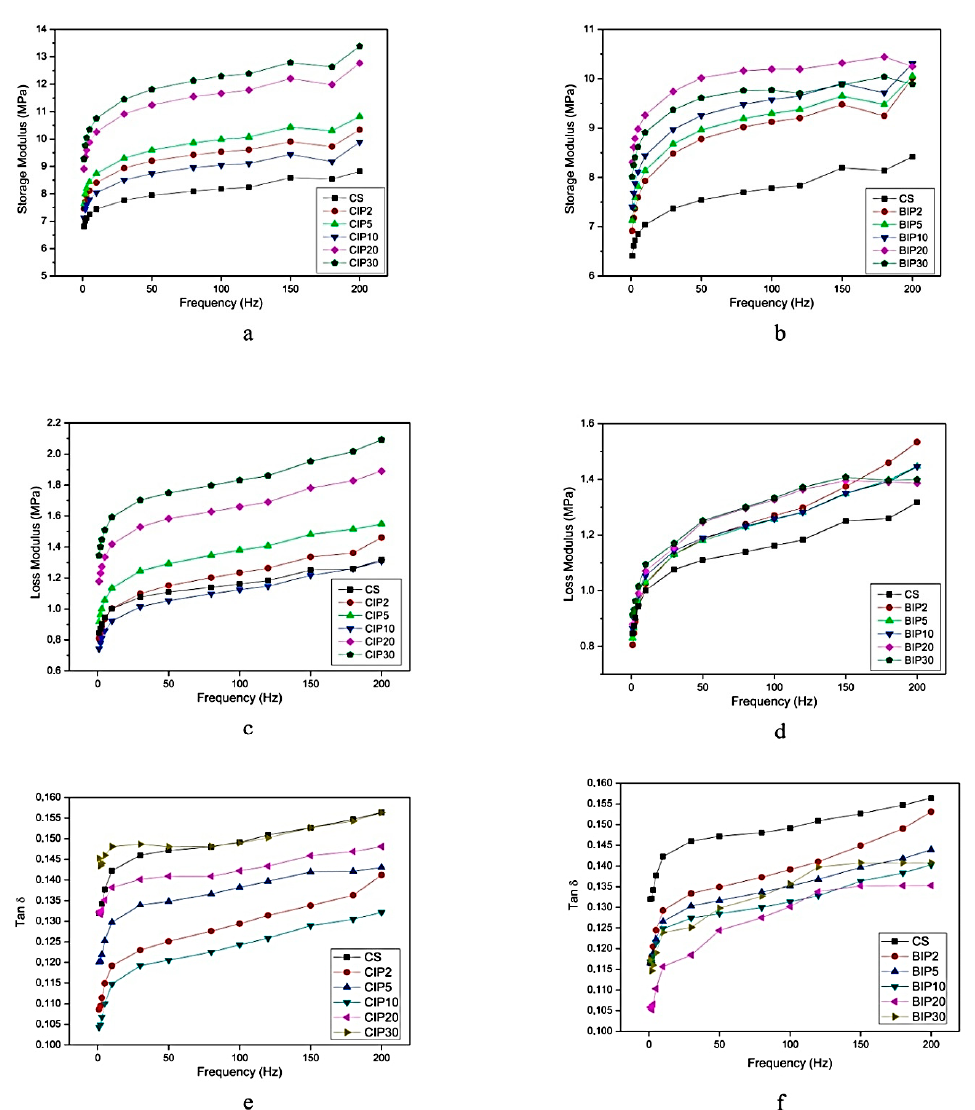
Figure 9. Dynamic properties of EPDM-based isotropic MREs, including storage modulus. ( a ) MRE containing CIPs; ( b ) MRE containing BIPs, loss modulus; ( c ) MRE containing CIPs; ( d ) MRE containing BIPs, and Tan δ ; ( e ) MRE containing CIPs; ( f ) MRE containing BIPs as a function of frequency [24] (reprinted with permission from Elsevier TM ).